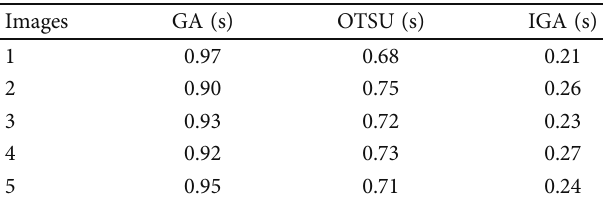
Table 4: Medical image segmentation running time.